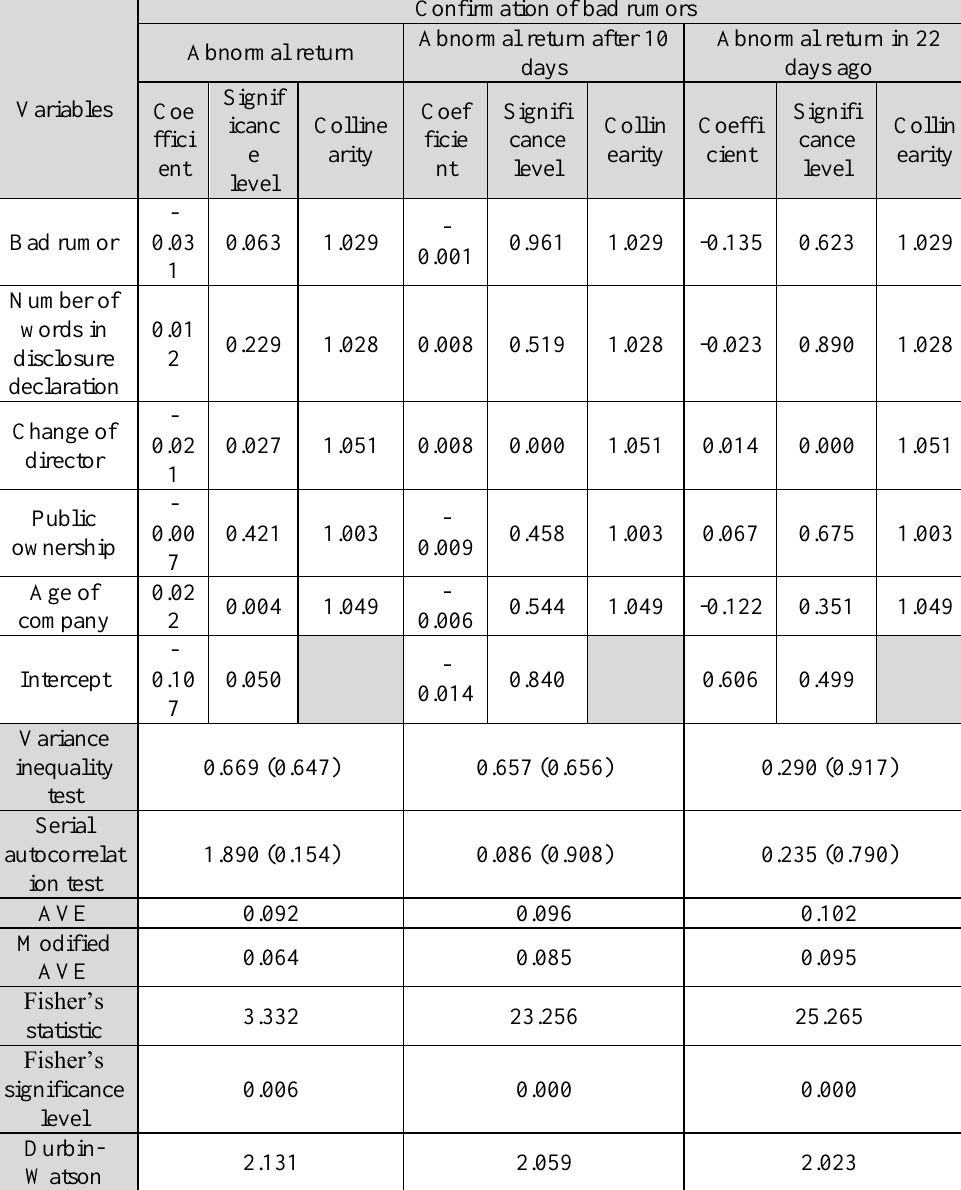
Table 9. Final estimation of the regressive model in third major hypothesis (Confirmation of bad rumors and abnormal return, abnormal return at 10 subsequent